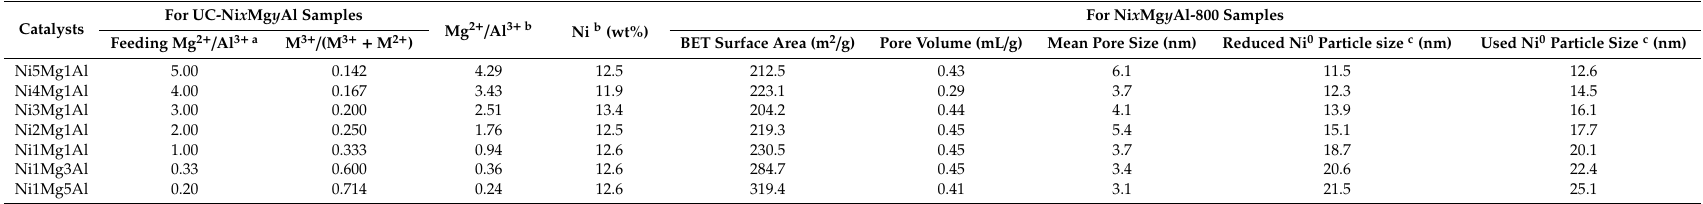
Table 1. Crystallographic parameters of the uncalcined samples and physicochemical properties of the relative Ni x Mg y Al catalysts. For UC-Ni x Mg y Al Samples Catalysts Feeding Mg 2 + / Al 3 +